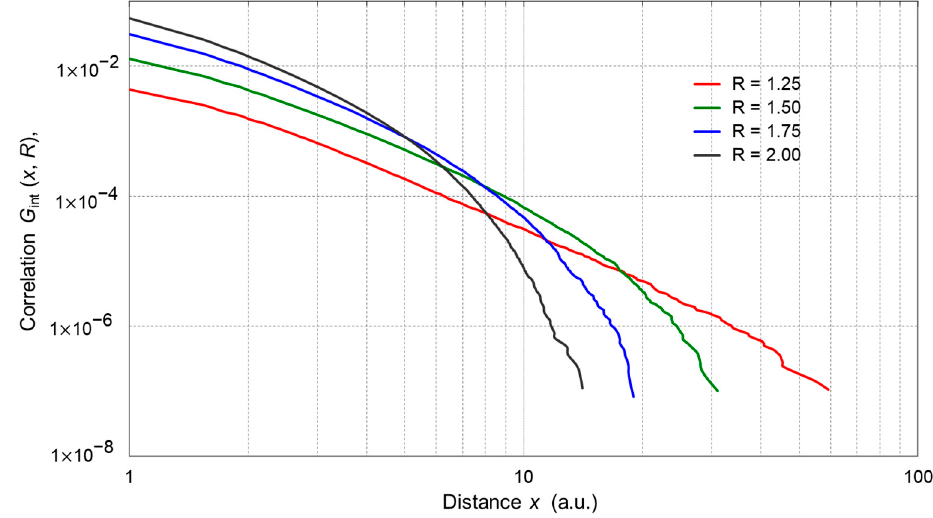
Figure 2. Influence of the disorder R on changes in the correlation of spin flips G int ( x , R ) and the dynamics of the magnetization process.